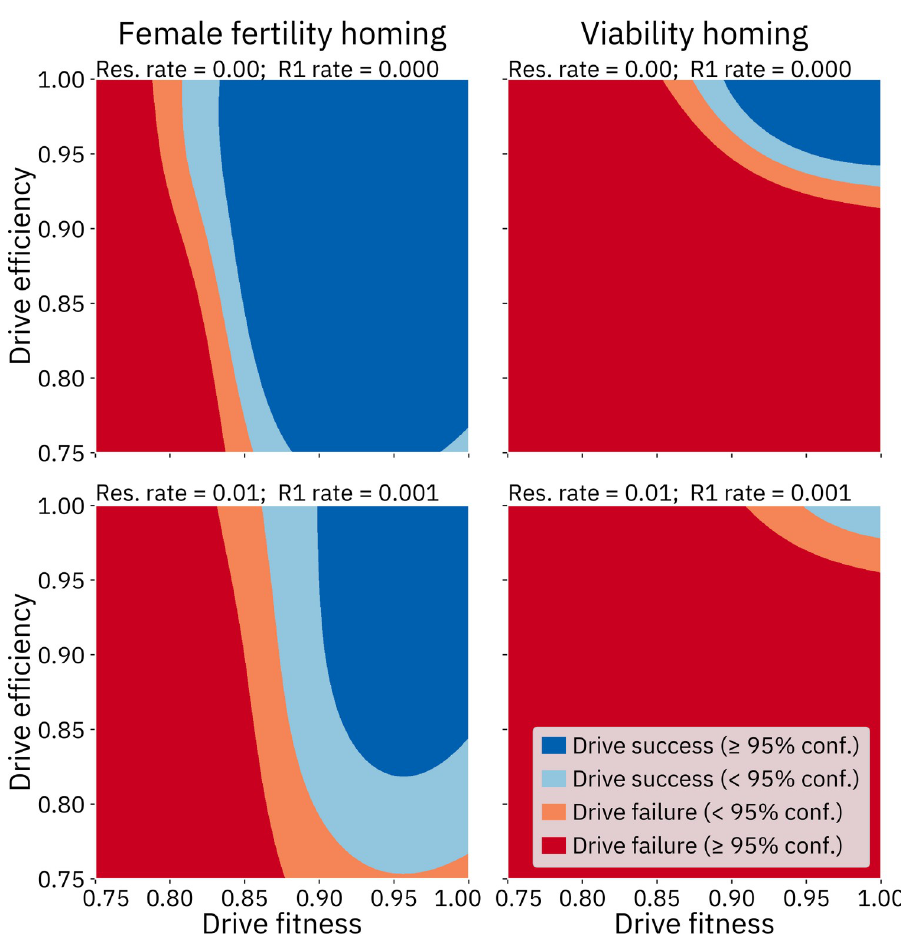
Fig 14. Comparison of the two homing drives with varying drive fitness, efficiency, and resistance parameters. Survival rate was set to 0.8, and other parameters were fixed at default values.